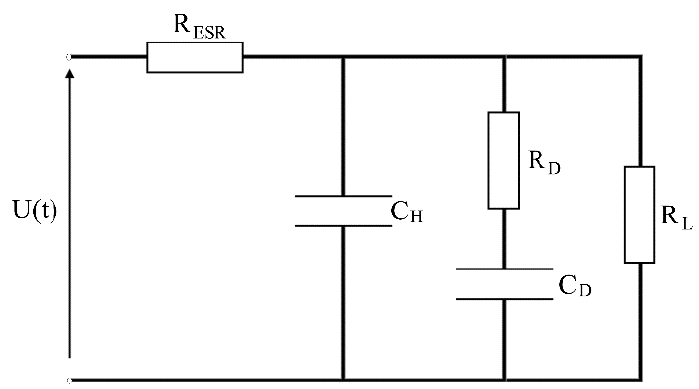
Figure 1. Equivalent electrical circuit of the supercapacitor.